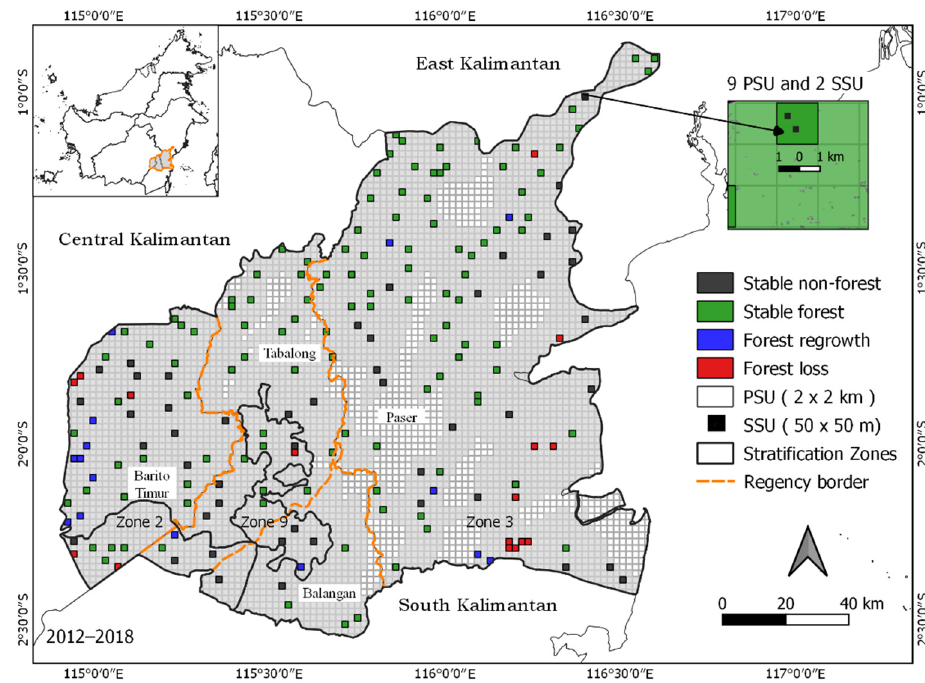
Figure 1. Sampling design of proportional distribution based on the two-stage stratified random sampling for the ADP map in 2012–2018 (the grey background refers to the availability of refer- ence images).